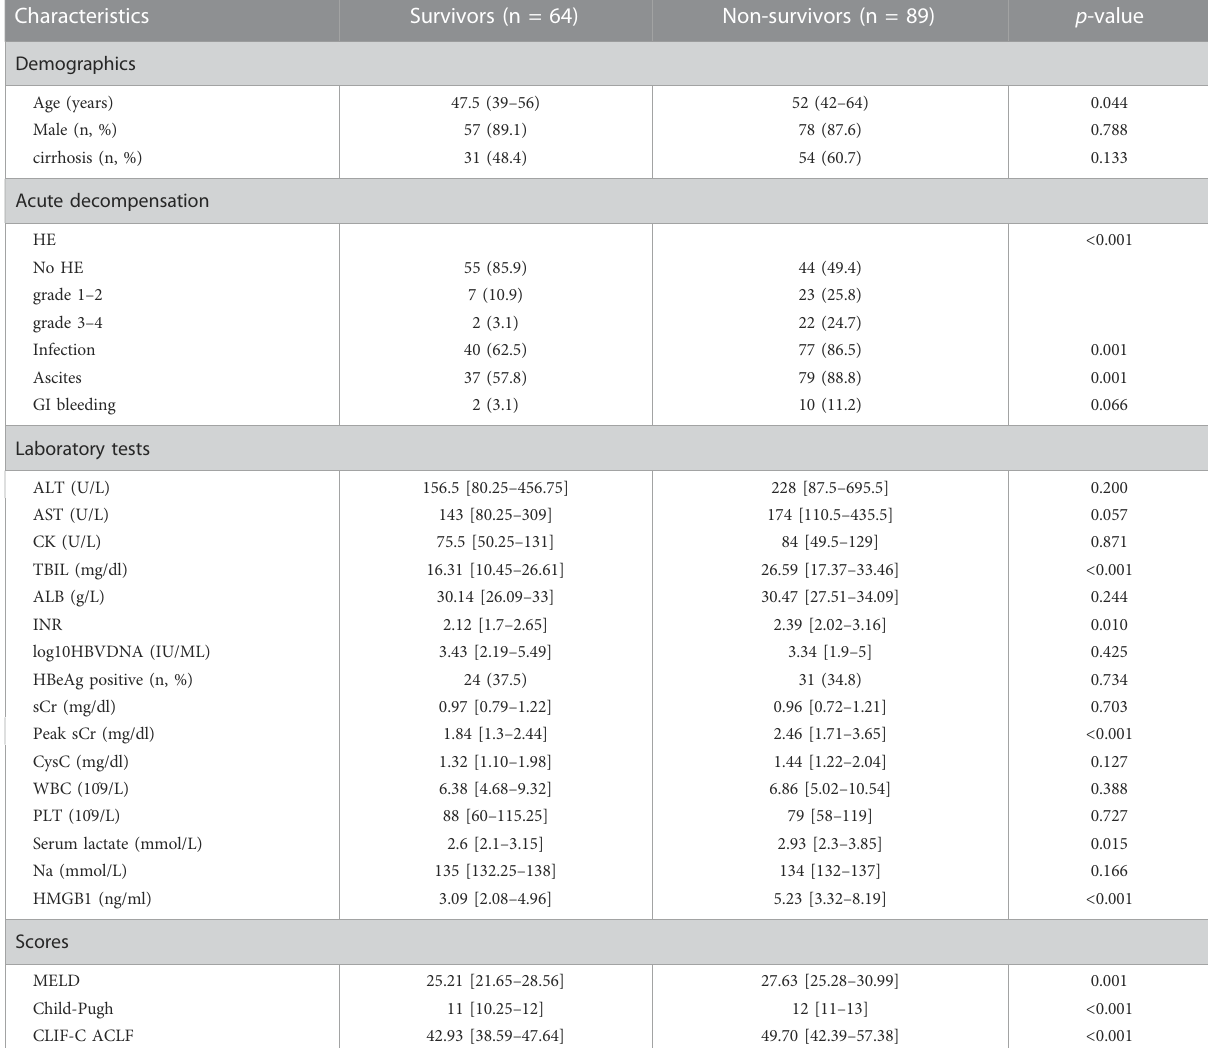
TABLE 3 Baseline characteristics of HBV-ACLF patients with AKI based on different prognostic groups at admission.